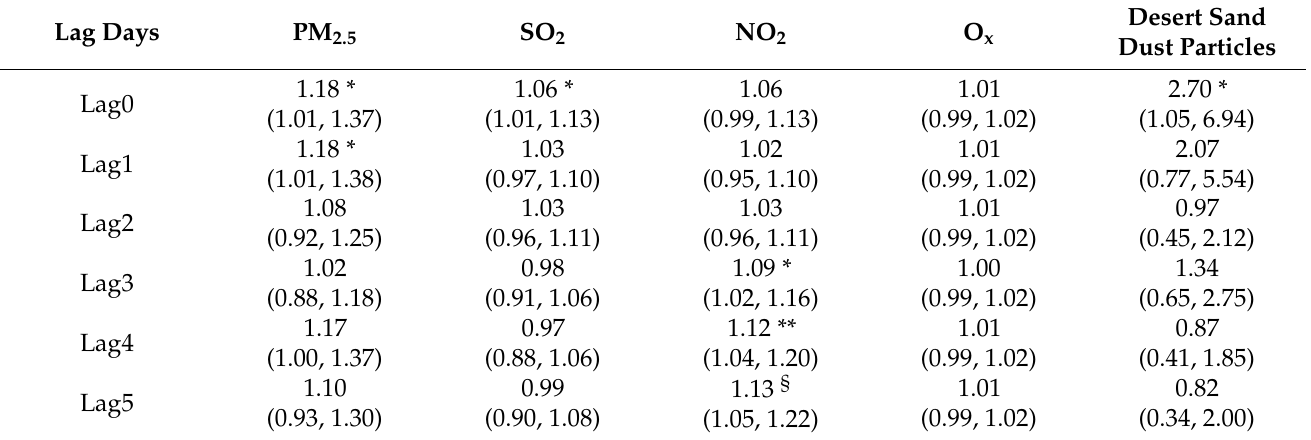
Table 6. Estimated relative risk and 95% confidence interval for absence from school due to cough associated with a 10- µ g/m 3 increase in PM 2.5 , a 1-ppb in NO 2 , SO 2 and O x and a 0.1-km − 1 in desert sand dust